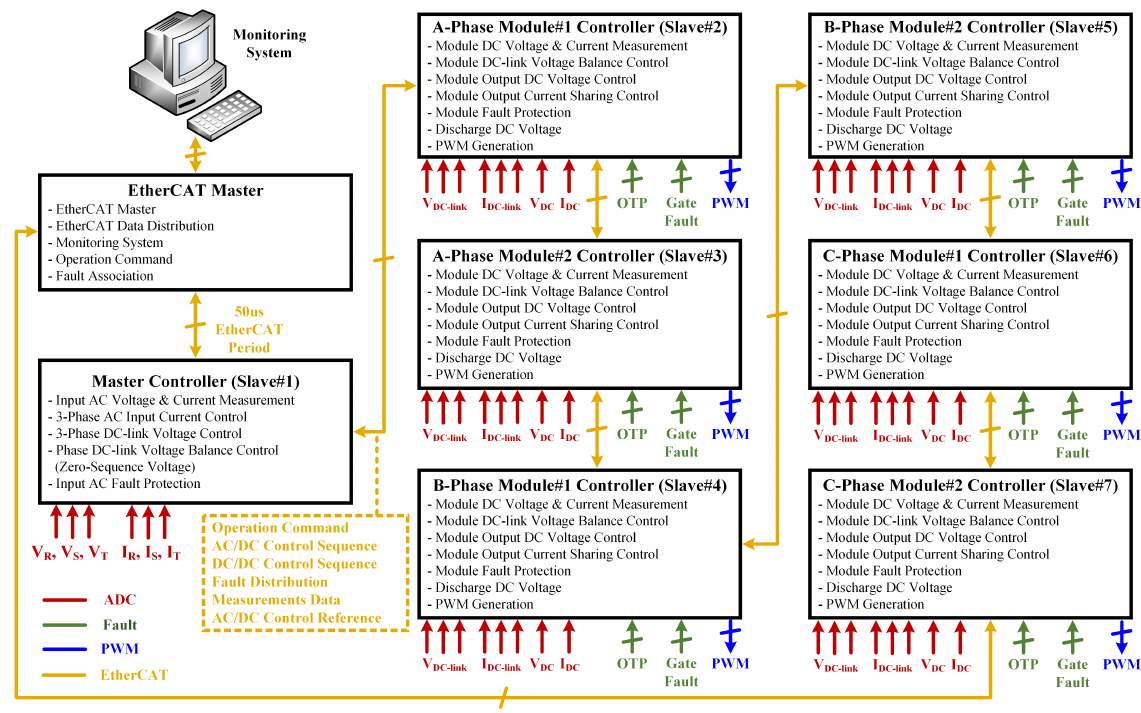
Figure 9. The proposed communication strategy for a 13.2 kV class 3-phase solid state transformer.